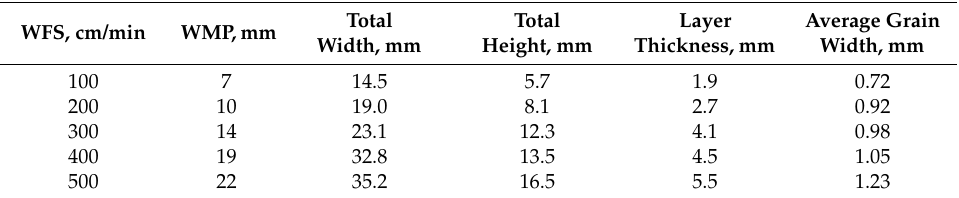
Figure 6. Temperature verification on the measuring positions of ( a ) P1 and ( b ) P2.